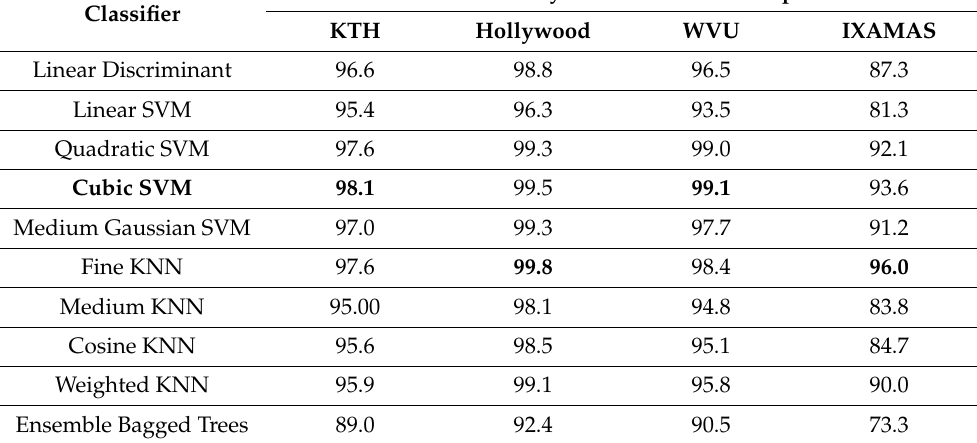
Table 2. Classification accuracy on specific InceptionV3 deep model. The bold represents the best obtained values.